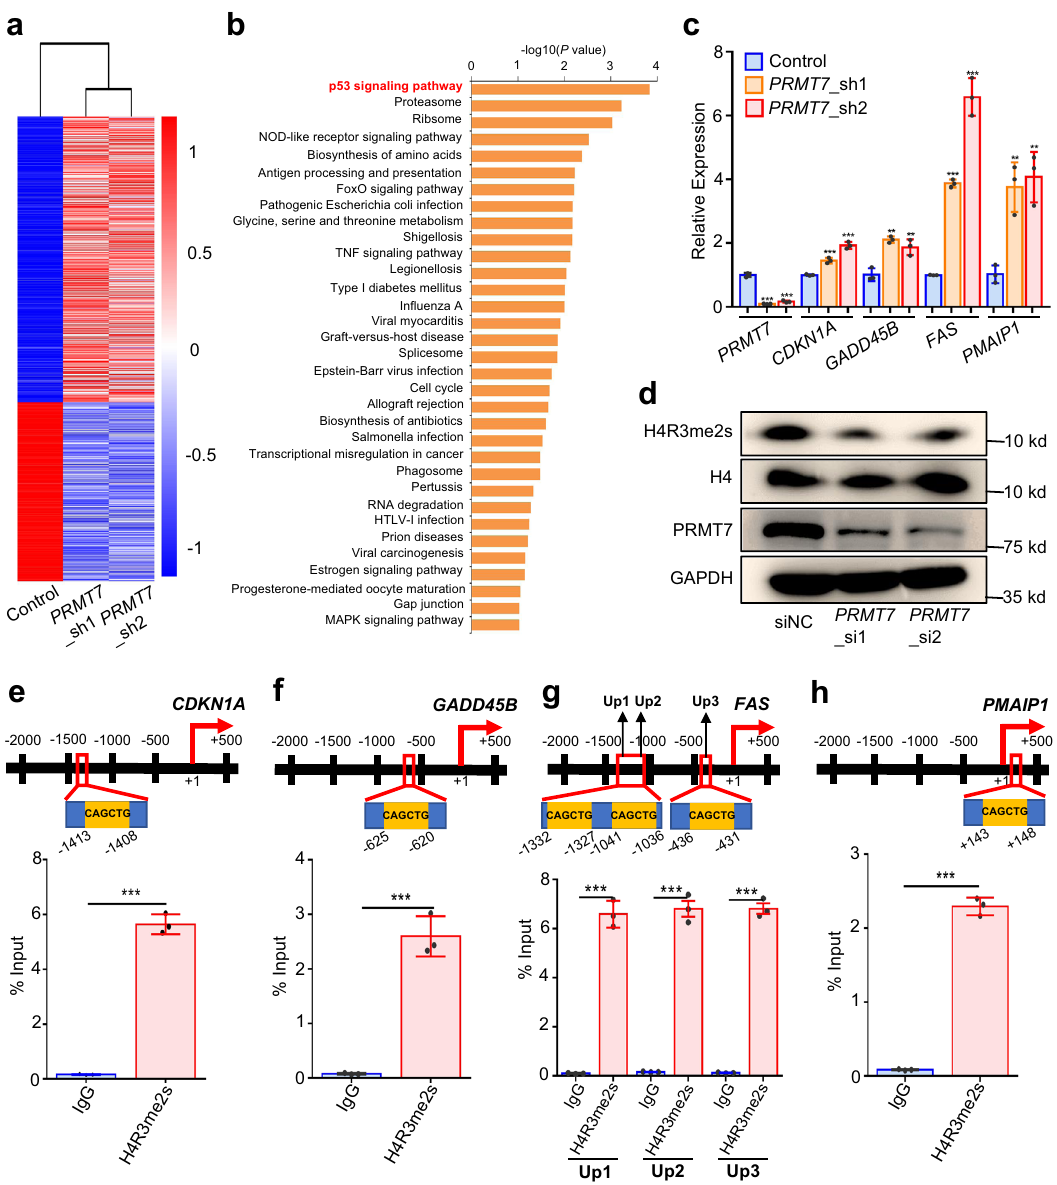
Fig. 6 The p53 signaling pathway is regulated by PRMT7 in HCC cells. a HeatMap of the differentially expressed genes was analyzed using RNA-seq data after PRMT7 knockdown in QGY-7703 cells. b Functional enrichment of the differentially expressed genes for KEGG was analyzed using DAVID bioinformatics resources. The p53 signaling pathway is highlighted in red. c qPCR detection of RNA level of four genes enriched in the p53 signaling pathway before and after PRMT7 knockdown in QGY-7703 cells, respectively. PRMT7 , P < 0.0001; CDKN1A, P = 0.0009 and P = 0.0001; GADD45B , P = 0.0011 and P = 0.0093; FAS , P < 0.0001; PMAIP , P = 0.0046 and P = 0.0033, in PRMT7 _sh1 or PRMT7 _sh2 compared to Control. d Western blot detection of H4R3me2s signal in the control and PRMT7 -downregulated samples in QGY-7703 cell line. Source data are provided as a Source Data fi le. This experiment is replicated two times at least and similar results are observed. e – h The enrichment of H4R3me2s modi fi cation on the promoter region of four genes, CDKN1A ( e ), GADD45B ( f ), FAS ( g ), and PMAIP1 ( h ), in the p53 signaling pathway was detected by ChIP-qPCR. Up1, Up2, and Up3 are the three sequences with CAGCTG motif in the promoter region of FAS . P < 0.0001 in HNF4A compared to IgG in e – h . Values are expressed as the mean ± SD, n = 3 in c and e – h . *, **, and *** mean P -values less than 0.05, 0.01, and 0.001, respectively (two-sided student ’ t